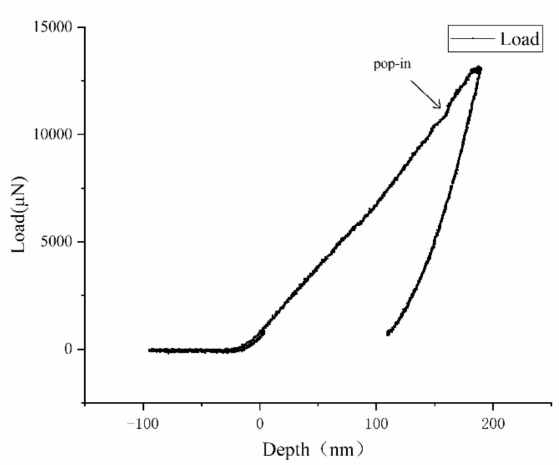
Figure 12. Loading and unloading curves under 13